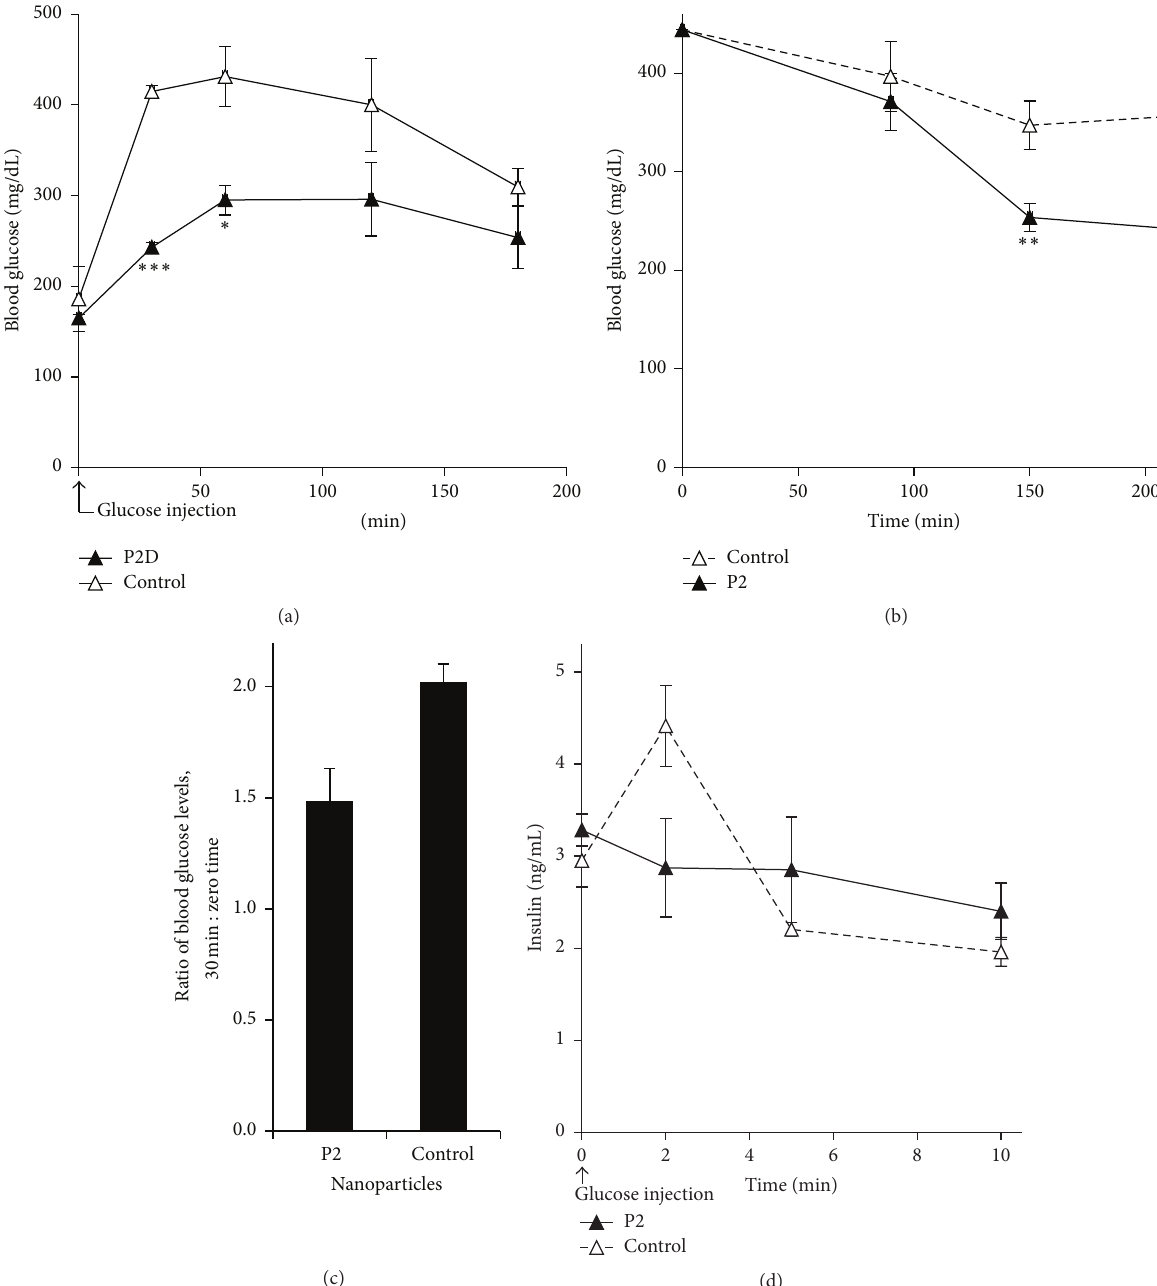
Figure 3: P2-nanoparticles modulate circulating glucose level. (a) Glucose tolerance test in wild-type mice; P2-nanoparticles lower blood glucose level. C57Bl/6J mice were deprived of food overnight. After anesthesia, P2- or control nanoparticles (1.1 𝜇 g peptide/g body weight) were injected ip, followed by glucose injection 10min later (1.5 mg/g body weight). Blood glucose was measured with a portable glucometer at the times shown. The values are mean ± sem for four mice in each group. ∗ 𝑃 < 0.05 , ∗∗∗ 𝑃 < 0.001 . (b) Glucose tolerance test in Ob/Ob mice-P2-nanoparticles lower blood glucose level. Anesthetized mice were injected with P2- or control nanoparticles, and blood glucose was measured starting 30min later, for the times indicated in the figure. Data points are mean ± sem for three mice in each group ∗∗ 𝑃 < 0.01 . (c) P2-nanoparticles attenuate hyperglycemia induced by ketamine-xylazine anesthesia in fed Ob/Ob mice. Blood was withdrawn for glucose measurement as soon as the mice became unconscious. Second sample was taken at 30 min after nanoparticle injection. Data are presented as the mean ratio of blood glucose at 30min to that at zero time, ± sem. The difference in mean ratio is significant; 𝑃 < 0.05 . (d) Glucose stimulation of insulin secretion is suppressed by P2-nanoparticles in Ob/Ob mice. Ob/Ob mice were injected with P2- or control nanoparticles, followed by glucose injection (0.5 mg/g body weight). Blood was withdrawn at the indicated times, and insulin was measured by ELISA. The data shown are the mean ± sem for three mice in each